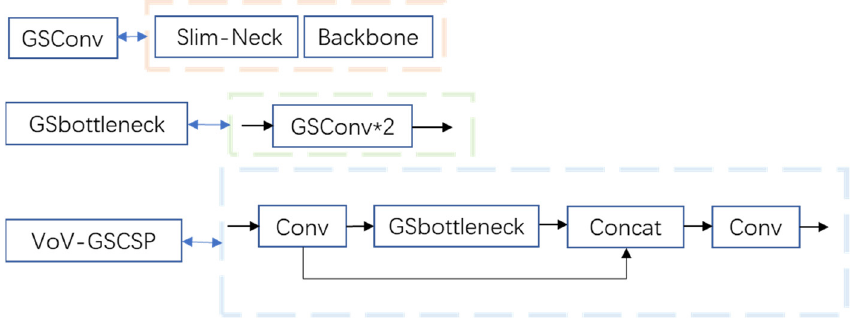
Figure 3. Structure of GSConv and VoV-GSCSP